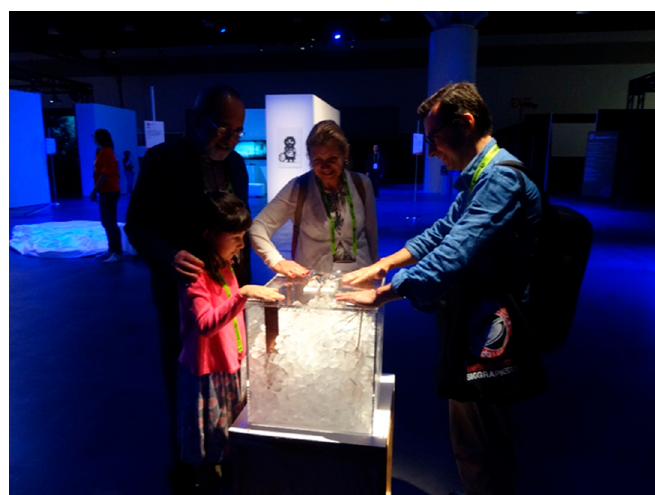
Figure 4. “Toque” (2016) produced by the cAt Research Group, Milton Sogabe, Fernando Fogliano and team. Photograph by Milton Sogabe. Used by permission of Milton Sogabe.